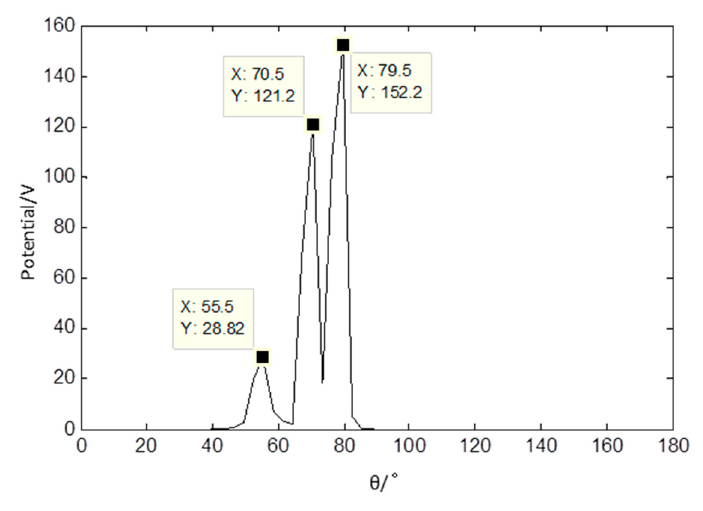
Figure 5. Potential function of the mixed signals.